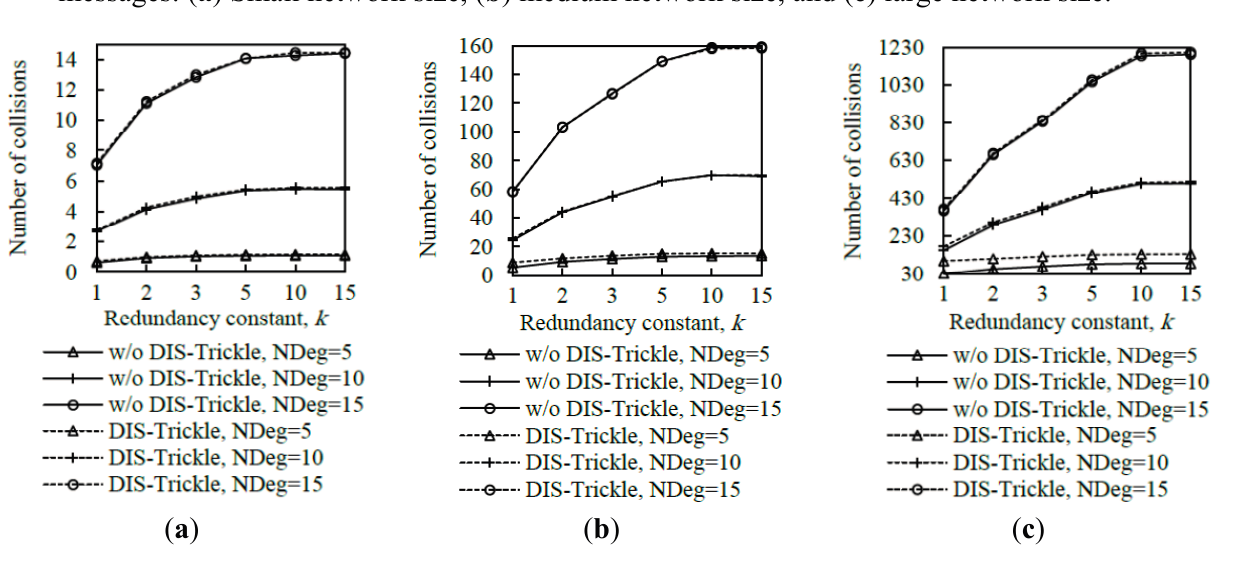
Figure 20. Influence of using DIS-Trickle on the number of collisions in the small, medium and large networks for different average node degrees, NDeg, as a function of the redundancy constant, k , when the I value is set to 8 ms compared with not using DIS min